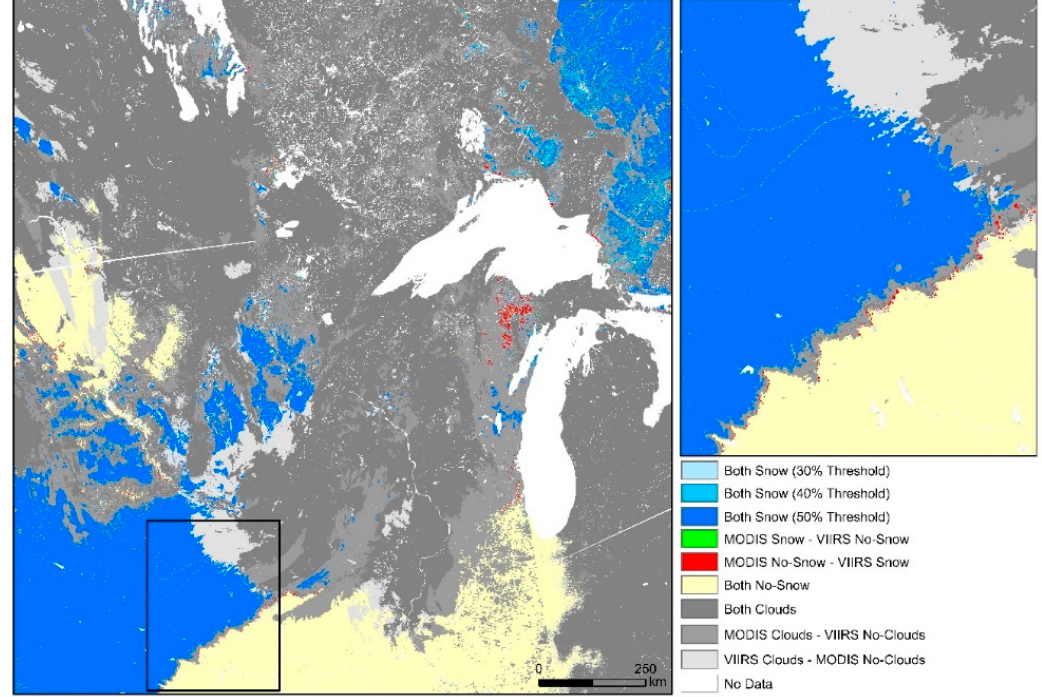
Figure 12. MODIS and VIIRS snow comparison map for 4 February 2016 illustrating disagreement over snow/no-snow transition zone where MODIS mapped cloud but VIIRS did not and snow/no-snow transition zone mapped as clouds.